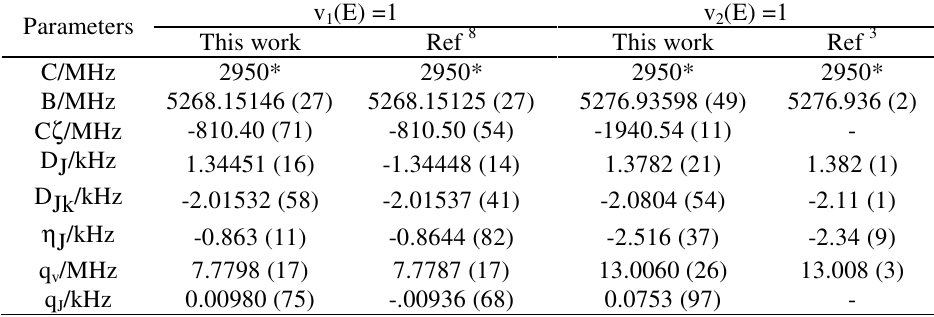
Table 10. Comparison of rotation-vibration parameters for (CH = 1 states.